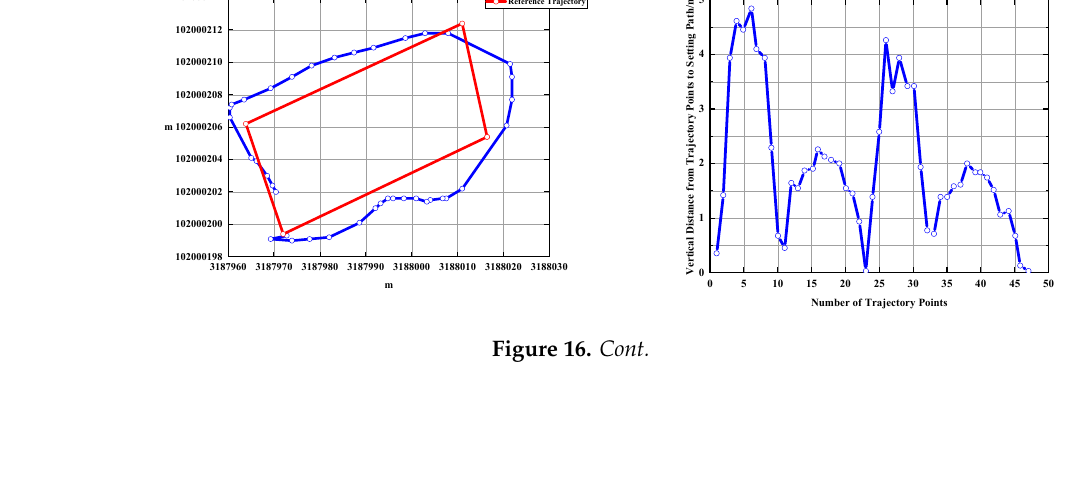
Figure 16. Square Path Test and Error Analysis ( a : before improvement; b : after improvement). 3.5.4. Discussion In order to solve the problem of path correcting and steering point controlling, the LOS algorithm has been improved. Combined with the system network control method, the path following experiments of triangle and square path tests are carried out, and the errors of path following before and after the improvement are compared, which proves that the improved algorithm has higher path following accuracy. Limited by the experimental conditions, the tests in this paper are carried out in a still water tank. Considering that in real sea conditions, the USV will be affected by wind, wave, current and other environmental disturbances, they can be regarded as external forces and added to the mathematical model by randomly combined cosine functions, which would lay the foundation for the application of the algorithms. 4. Conclusion Complete modeling, and control design for maneuvering a twin water-jetted USV along the desired path has been presented. The maneuvering procedure with tests have proved that the control system platform with intelligent navigation algorithm can improve the motion control and path following of the USV. The detailed works include: 1)